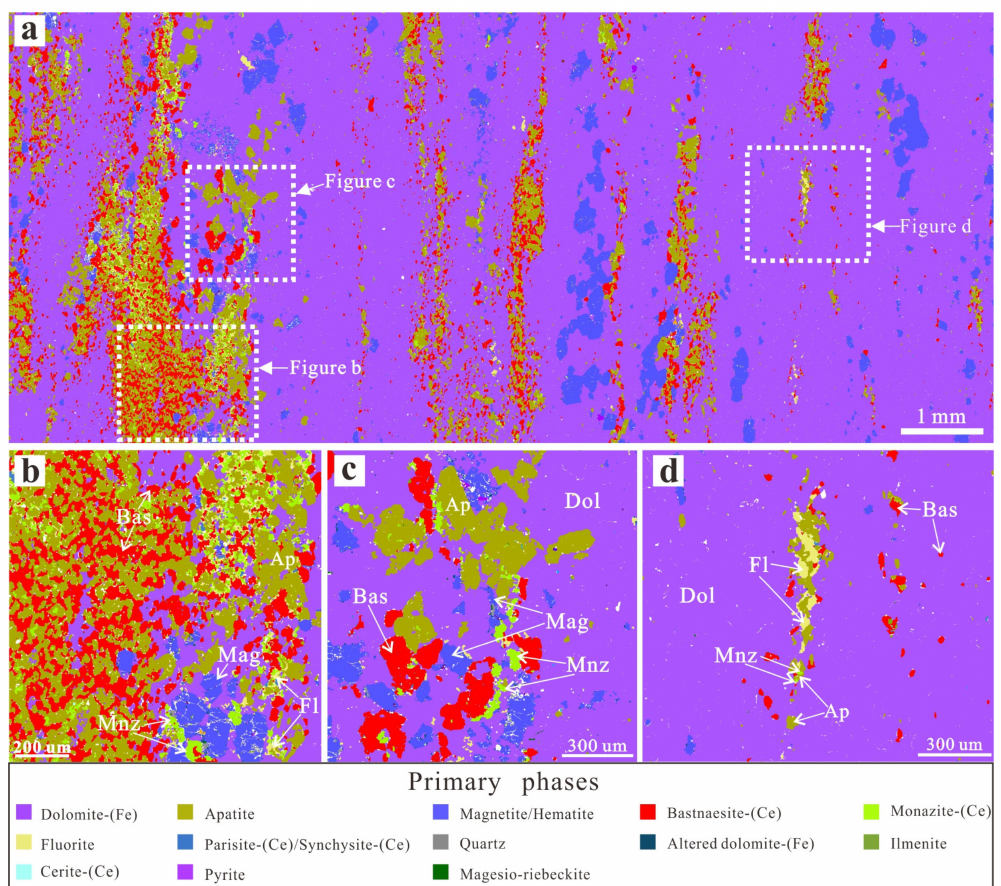
Figure 8. The TIMA false-colored mineral phase map of the 1546 m drill ore sample. ( a ) the whole image of the thin section shows banded deformation ore texture; ( b ) intergrowth of bastnäsite- (Ce), apatite, fluorite, and monazite-(Ce), as well as large-grain magnetite, in the form of parallel vein aggregates intruded into the dolomite-(Fe) matrix; ( c , d ) the association of the REE minerals (bastnäsite-(Ce) and monazite-(Ce) with apatite, forming scattered vein-like aggregates overprinted on the dolomite-(Fe). Abbreviations: Dol, dolomite-(Fe); Bas, bastnäsite-(Ce); Mnz, monazite-(Ce); Fl, fluorite; Mag, magnetite; Ap,